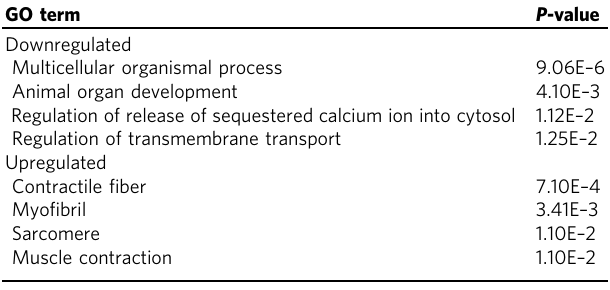
Fig. 7d, e), suggesting that the effect of Srf on reprogramming is common in a broad range of cell types.